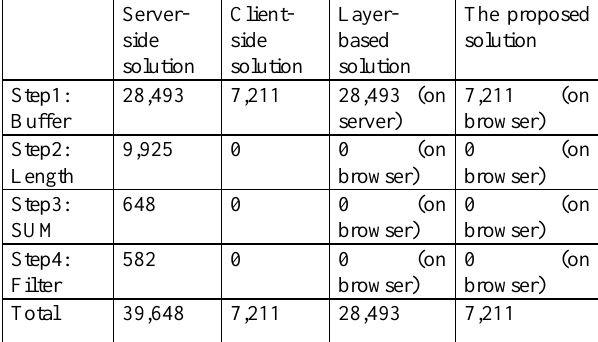
Table 2. Comparisons of the second case study (data amount is measured by Byte)